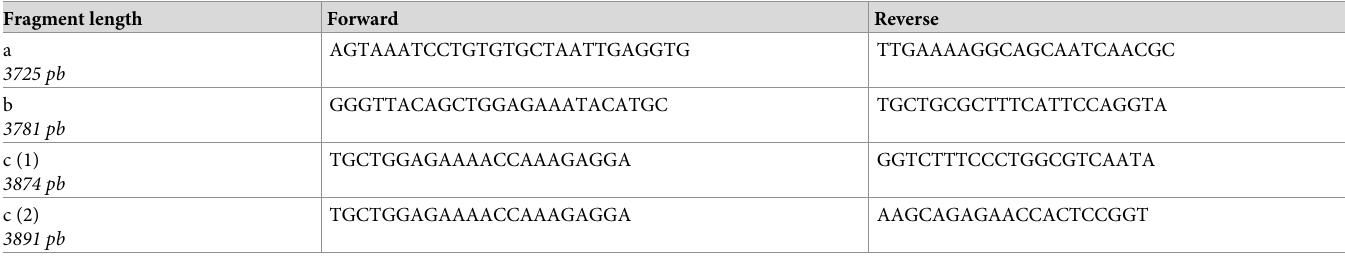
Table 1. Primers used for YFV